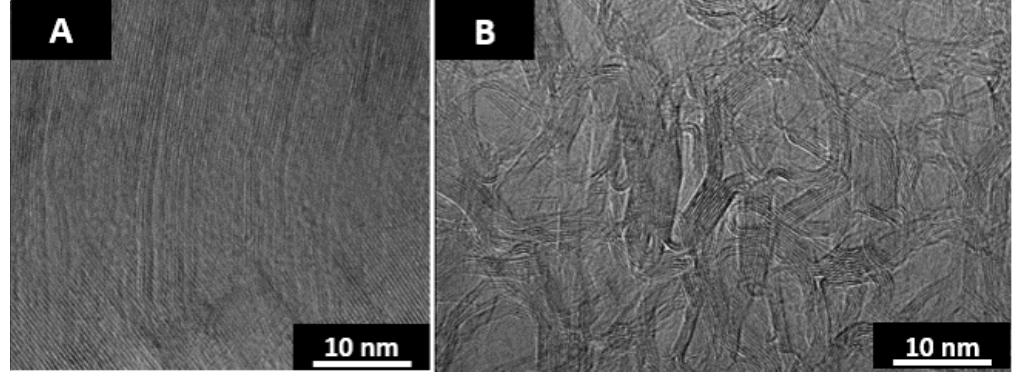
Figure 3. TEM micrographs of ( A ) anthracene coke and ( B ) fluorene char after furnace heat treatment at 2600 °C for 1 h.